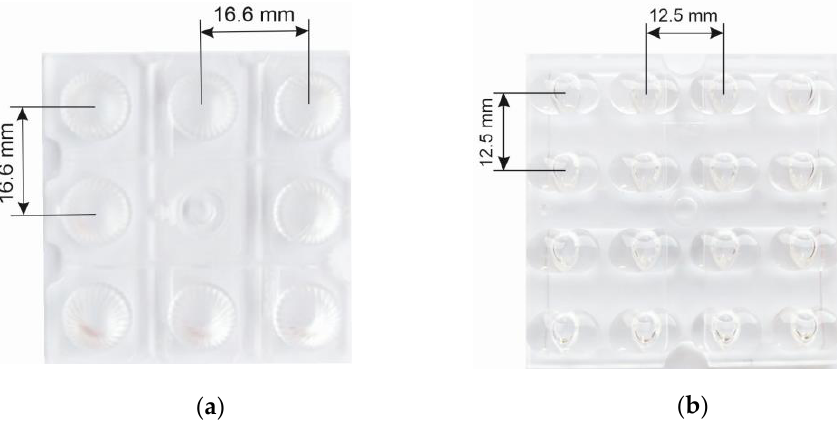
Figure 3. An example of multi-lens array systems with different distances between adjacent LEDs: ( a ) 16.6 mm, ( b ) 12.5 mm.